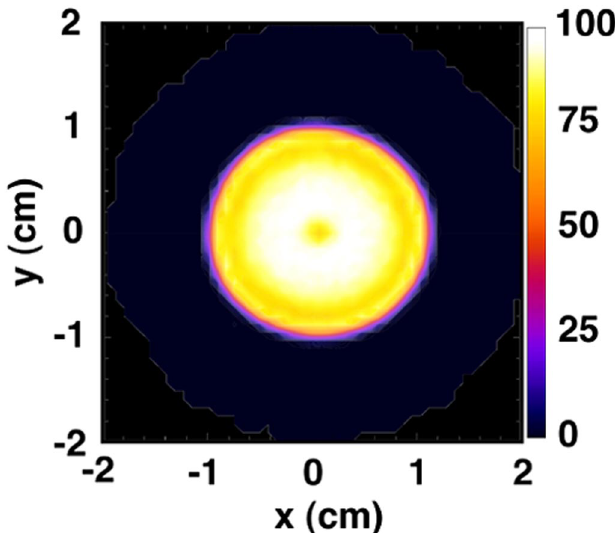
FIG. 13. (Color) Transverse beam distribution calculated 56 cm downstream of the exit of two solenoids at the scintillator plane ( z (cid:6) 187 cm ) using the recessed